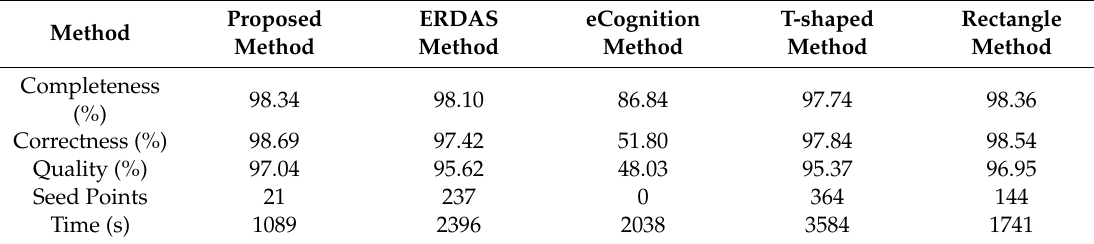
Table 1. Accuracy evaluation of the first study area.